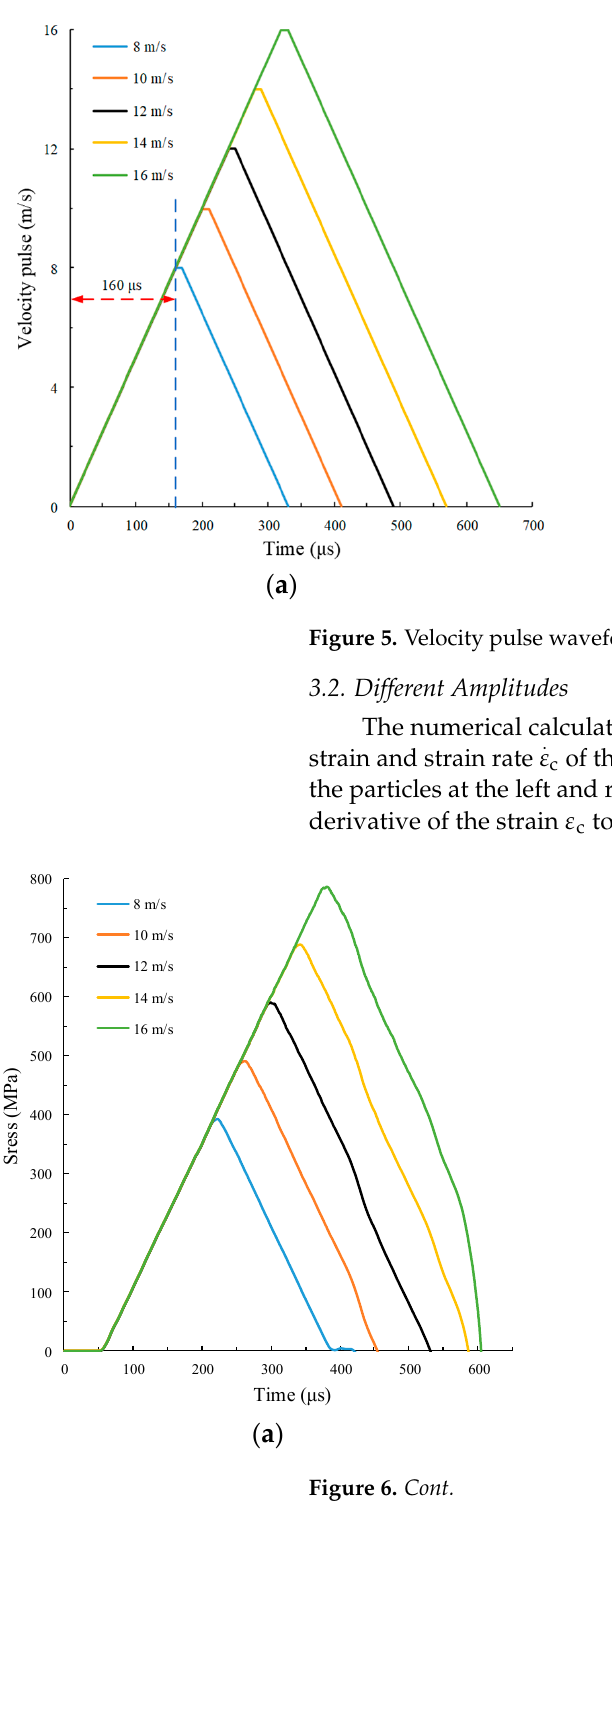
Figure 5b. The rise time t r = 50, 100, 150, 200 and 250 μ s respectively, and A v = 12 m/s.